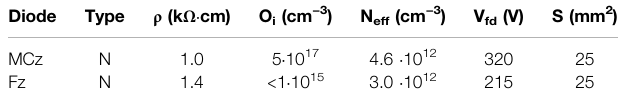
TABLE 1 | Main characteristics of the MCz and Fz diodes.